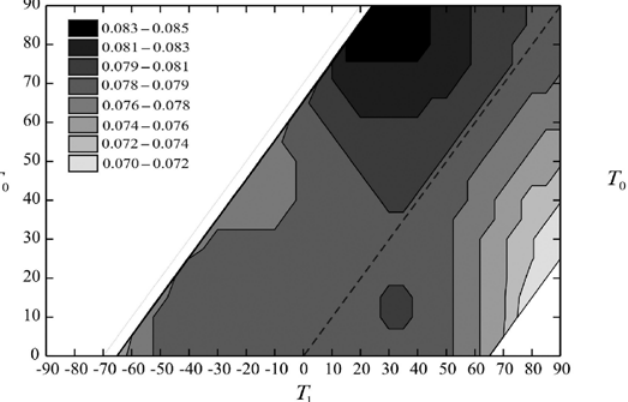
Figure 5: Contour plot of Ω for the clamped graphite/epoxy [  〈 T / T 〉] circular laminate. 0 1 s